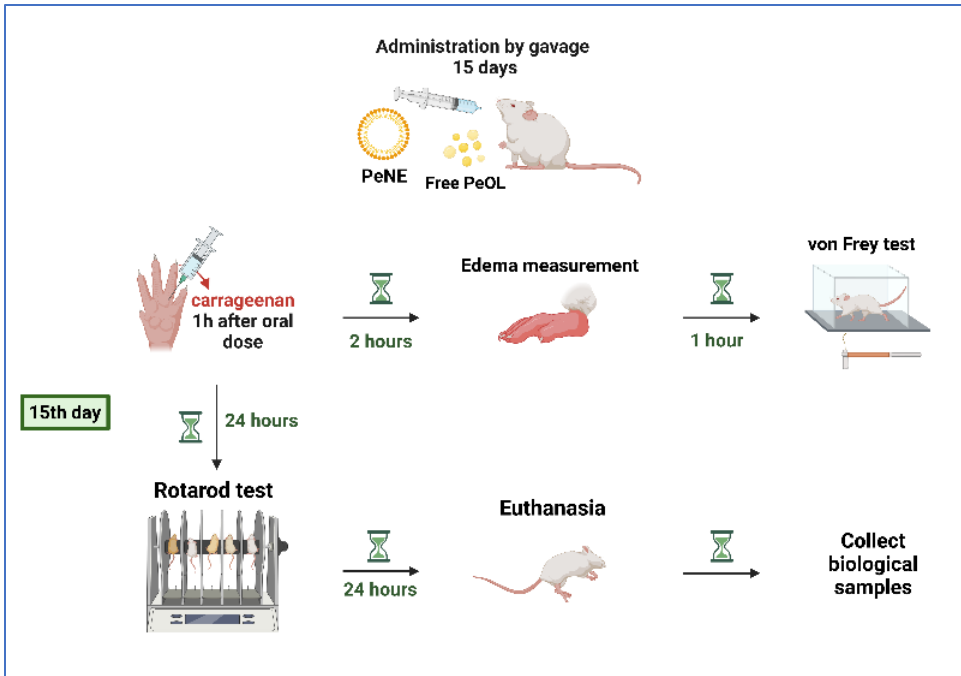
Figure 1. Experimental design of inflammation, hypernociception, and motor coordination assays performed with rats daily treated with PeNE (pequi oil nanoemulsion) or free pequi oil (p.o.) for 15 days.